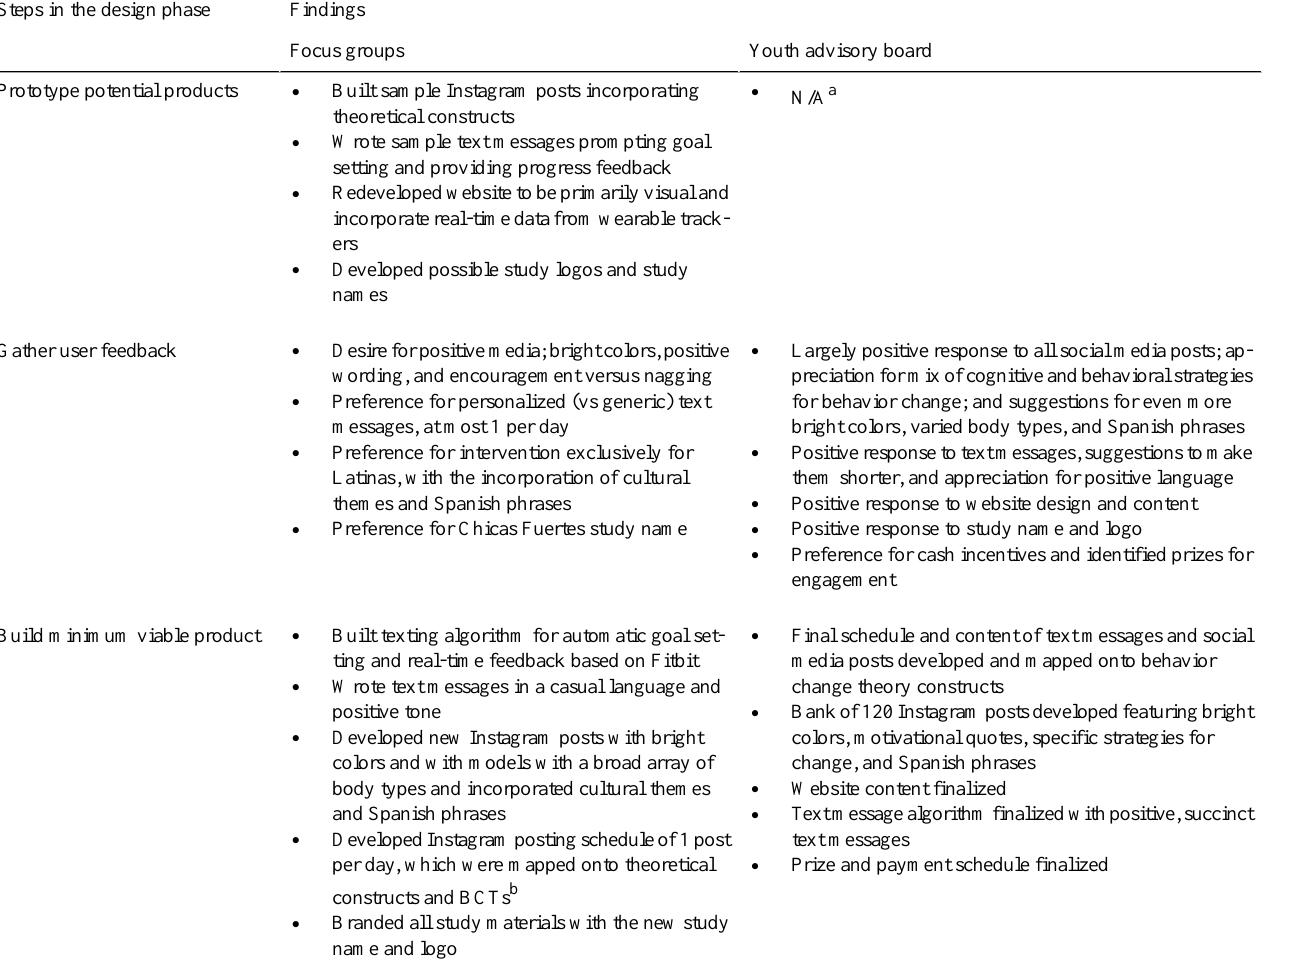
Table 2. Findings from the focus groups and youth advisory